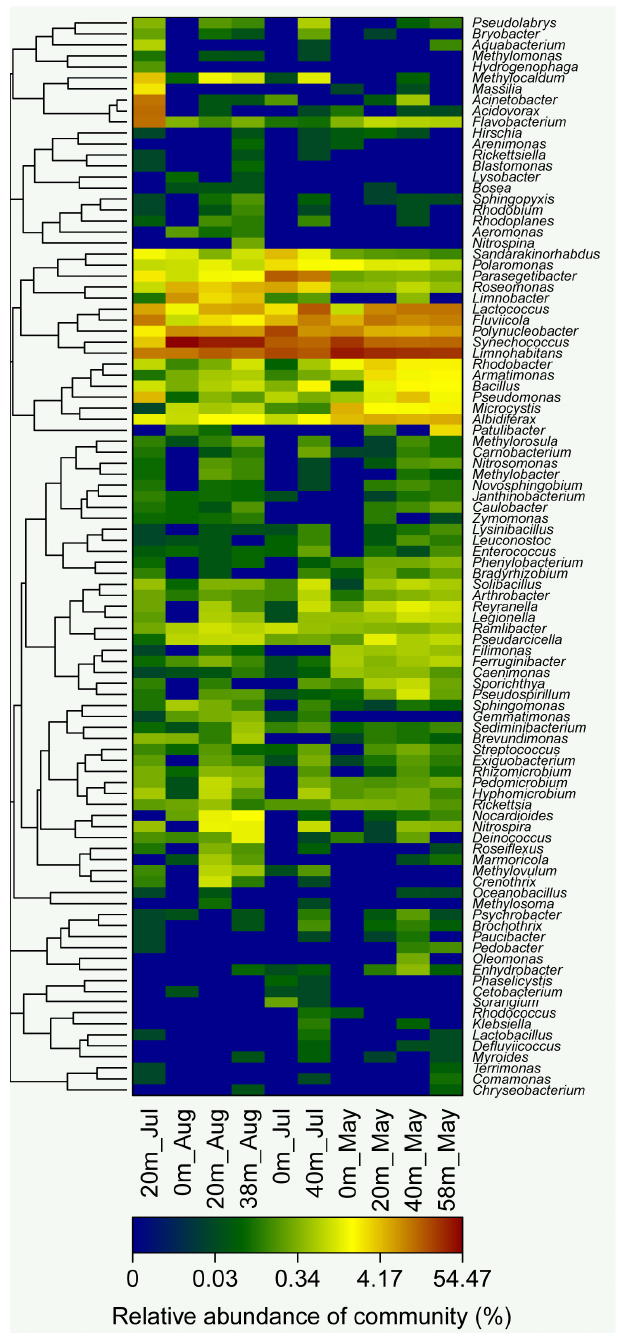
Figure 7. A color-scale heatmap showing 100 representative predominant 16S rRNA gene-based sequence classified at the genus level from the bacterial communities of the Jinpen Drinking Water Reservoir,